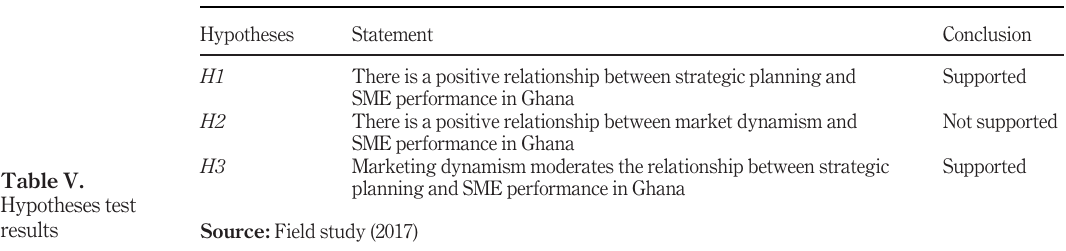
Figure 2. The moderating